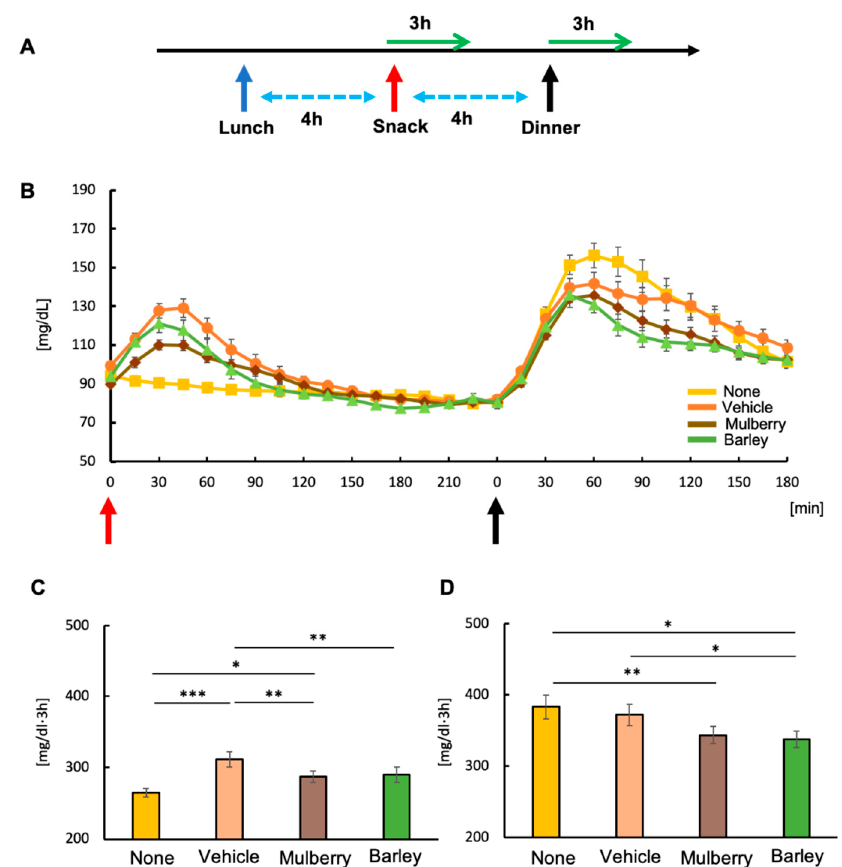
Figure 1. Changes in blood glucose levels. Study protocol ( A ), changes in glucose levels after the snack and dinner ( B ), area under the curve (AUC) of glucose levels 180 min after snack intake ( C ) and dinner intake ( D ). Values are means ± standard errors. * p < 0.05, ** p < 0.01, *** p < 0.001. Table 1. Meal time in each session.